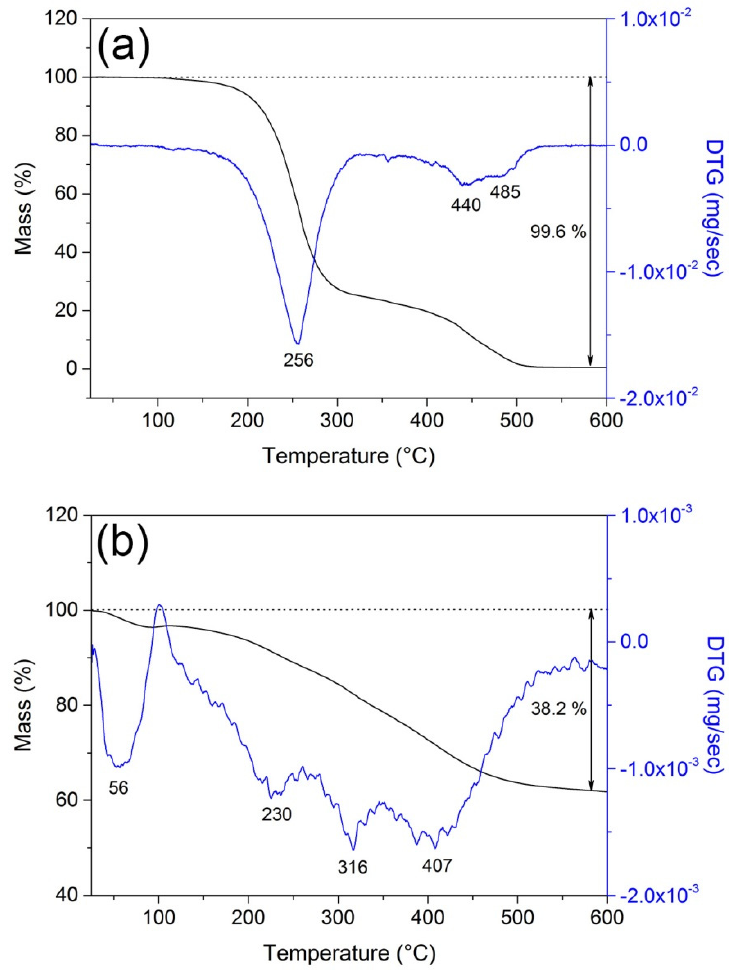
Figure 4. Thermogravimetric analysis results of ( a ) the gum rosin and ( b ) the prepared OMMT.